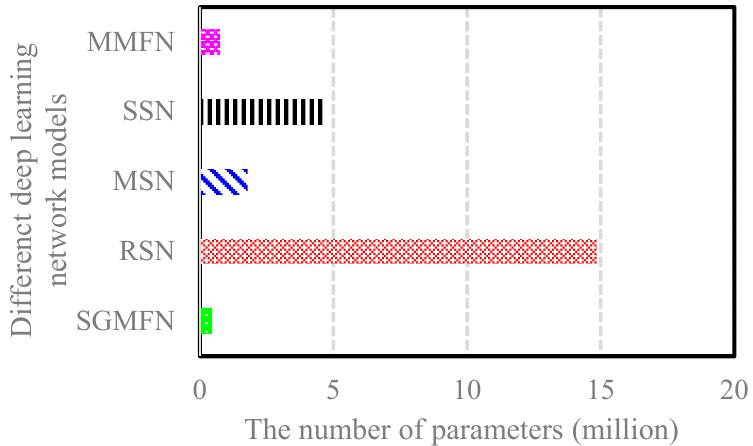
Figure 11. Comparison results of parameters of different network models.